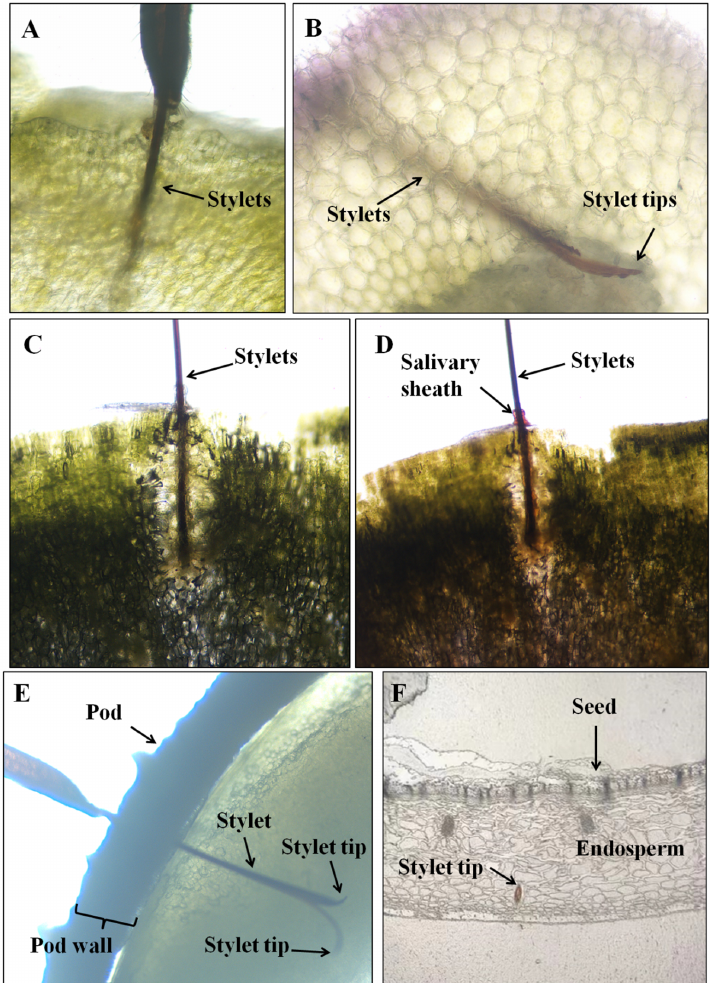
Figure 7. Cross sections of soybean cotyledons and pods containing severed stylets of R. pedestris during waveform Rp3. ( A – C ). Complete stylet tips ending in the cell tissue of cotyledon during waveform Rp3. ( D ). Complete salivary sheath stained with acid fuchsine ending in the cell tissue of cotyledon during waveform Rp3. ( E ). Complete stylet tips ending in the cell tissue of pod during waveform Rp3. ( F ). Complete stylet tips ending in the seed during waveform Rp3 (Paraffin sec- tion).